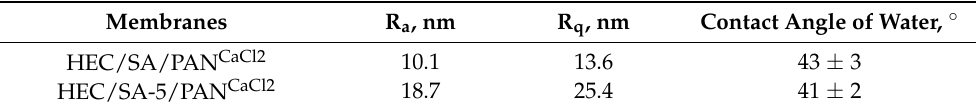
Table 6. Surface parameters of the supported HEC/SA/PAN CaCl2 and HEC/SA-5/PAN CaCl2 membranes. Membranes R a , nm R q , nm Contact Angle of Water, ◦ HEC/SA/PAN